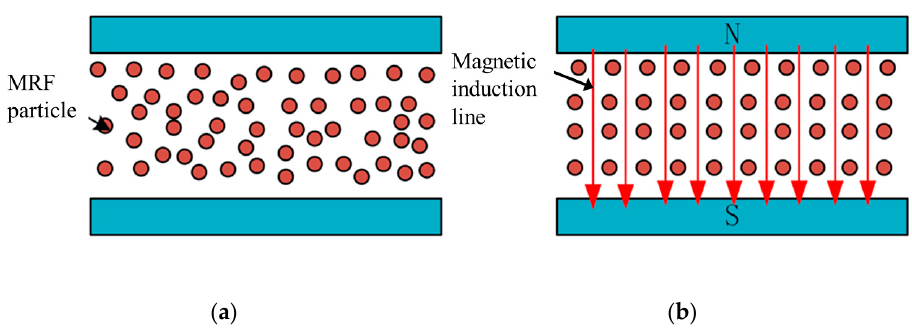
Figure 1. ( a ) Material properties of MRF without magnetic fi eld. ( b ) Material properties of MRF with a magnetic fi eld.